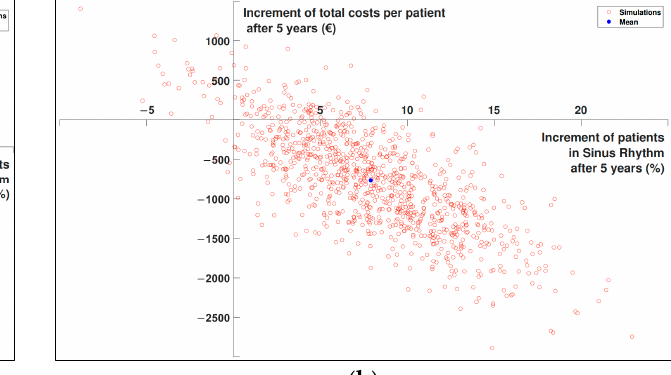
Table 5. Key values of the impact of the increase of ablations in Europe after five years with 25% more effectiveness of CA and including the price of the device.